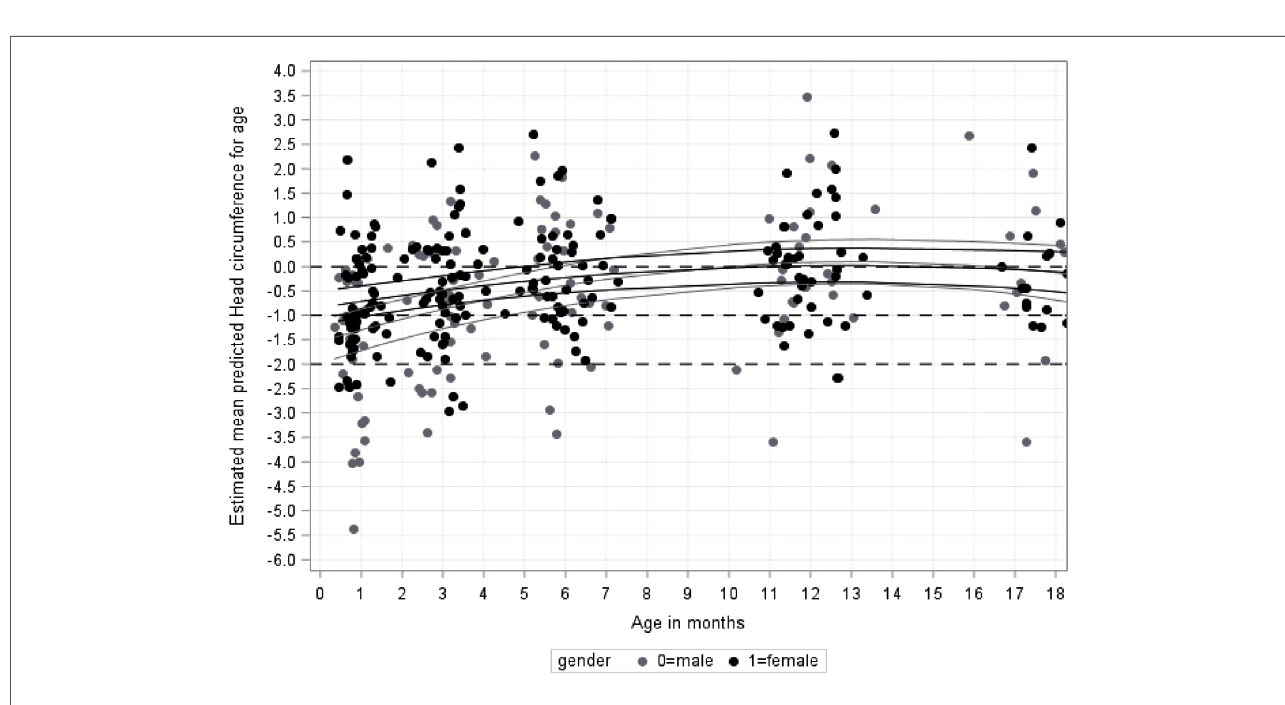
FIGURE 5 Growth for infant ’ s head-circumference z-score for age (HCZ) in cm from 1 to 18 months by